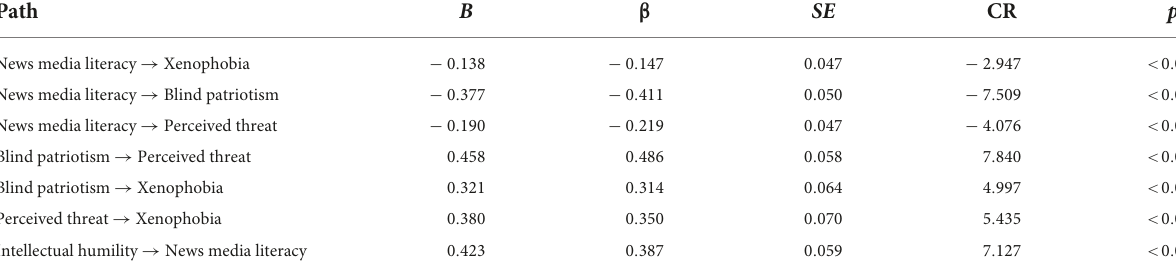
TABLE 5 Standardized regression weights according to the path